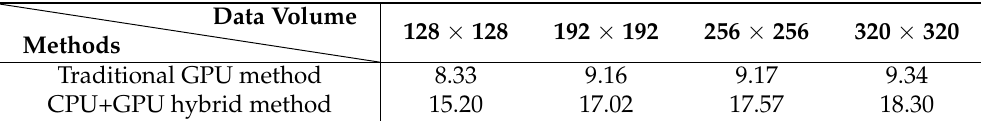
Figure 10. Comparison of the time consumption by different platforms. Table 2. Speedup ratio of the traditional GPU-only method and the hybrid CPU + GPU method compared to the CPU-only